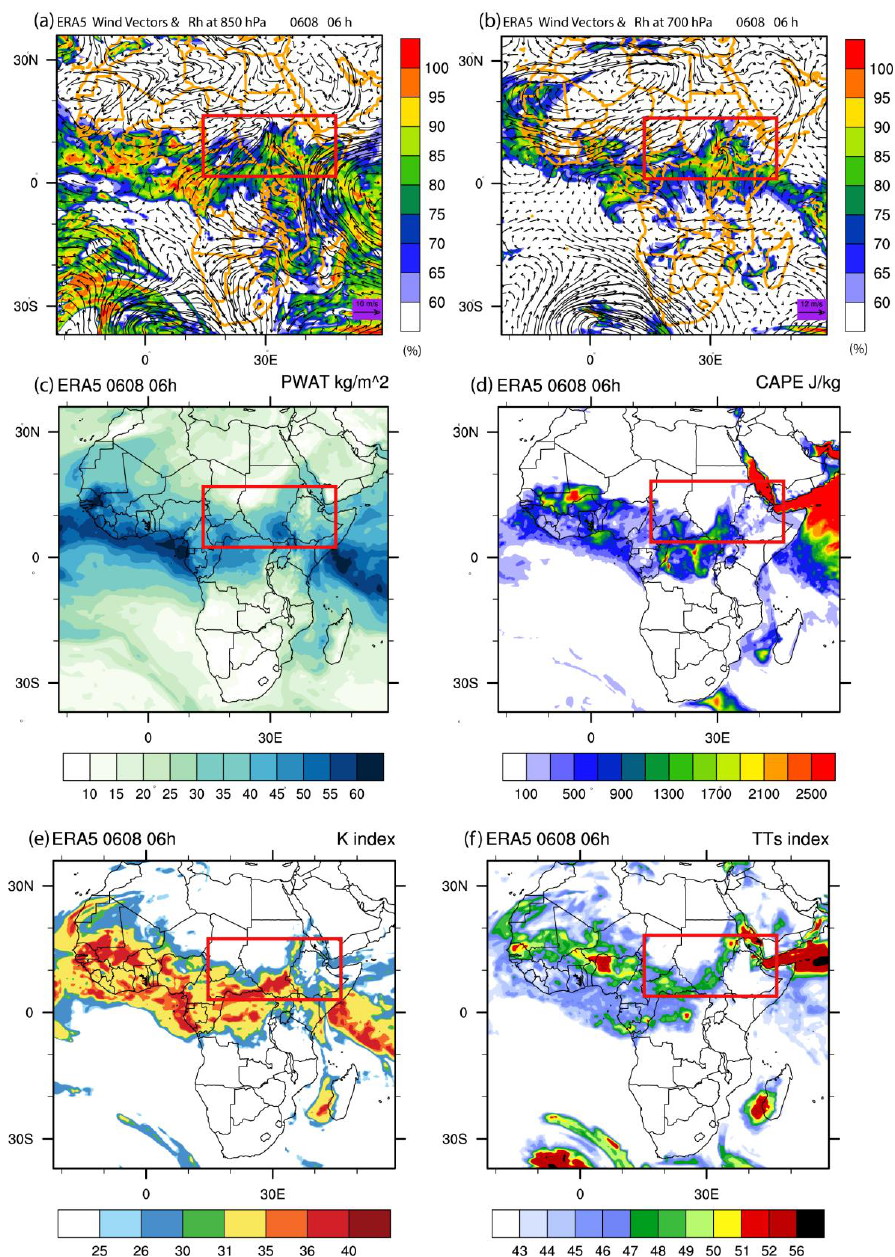
Figure 11. Synoptic analysis of ERA5 data at 6am (UTC) on 8 June 2020. ( a ) wind at 10 m (m/s; vectors) and relative humidity (%; shaded) at 850 hPa; ( b ) wind (m/s; vectors) and relative humidity (%, shaded) at 700 hPa; ( c ) precipitable water (kg/m 2 ); ( d ) convective available potential energy (J/kg); ( e ) K-index; and ( f ) total of totals index. The red box denotes the ROI (South Sudan–Ethiopia